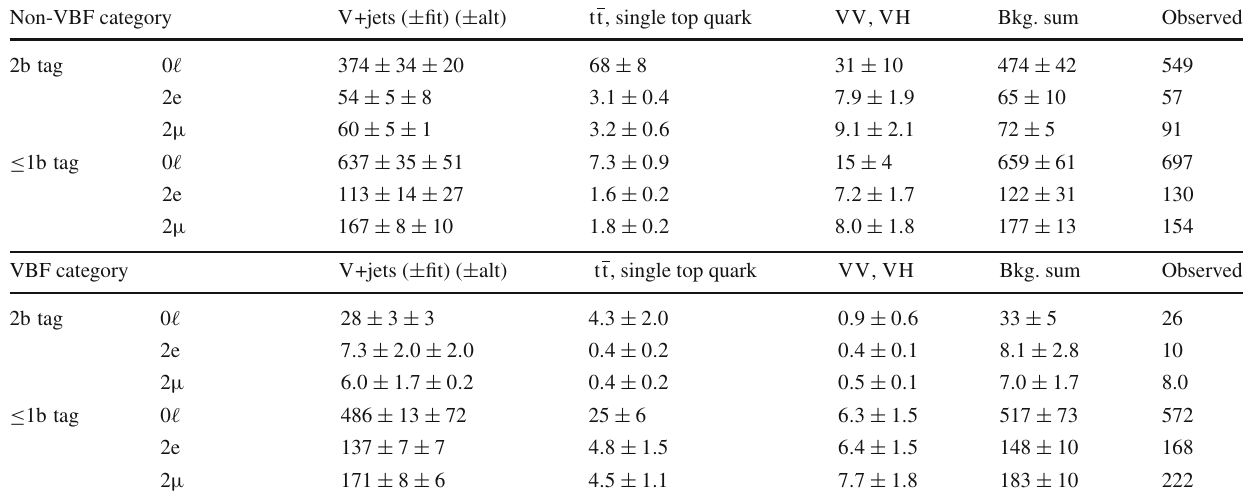
Table 3 The expected and observed numbers of background events uncertainties arise from the m j modeling, the statistical component of H the top quark SF uncertainties, and the extrapolation uncertainty from in the signal region for all event categories. The V+jets background the control region to the SR. The VV and VH normalization uncertain- uncertainties originate from the variation of the parameters within the ties come from the m j fit uncertainties (fit) and the difference between the nominal and alter- H nativefunctionchoiceforthefitto m j (alt).Thett andsingletopquark H